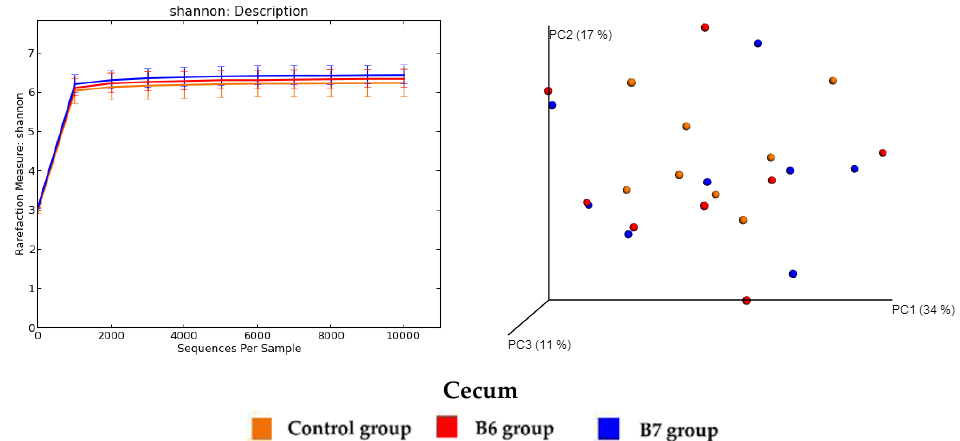
Figure 3. The Shannon α -diversity index (rarefaction curves) and β -diversity (weighted UniFrac principal component analysis).